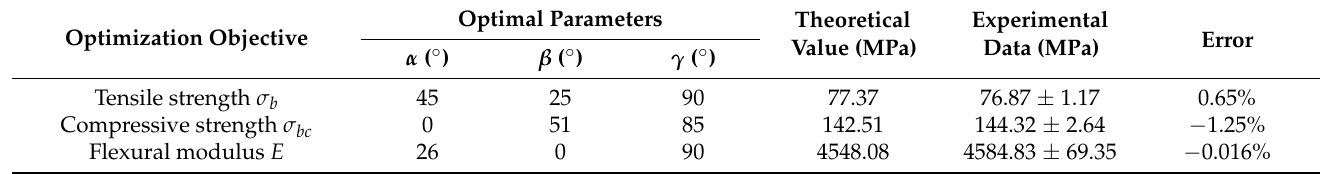
Table 8. Comparisons of optimal single mechanical property in theory with that in actuality.